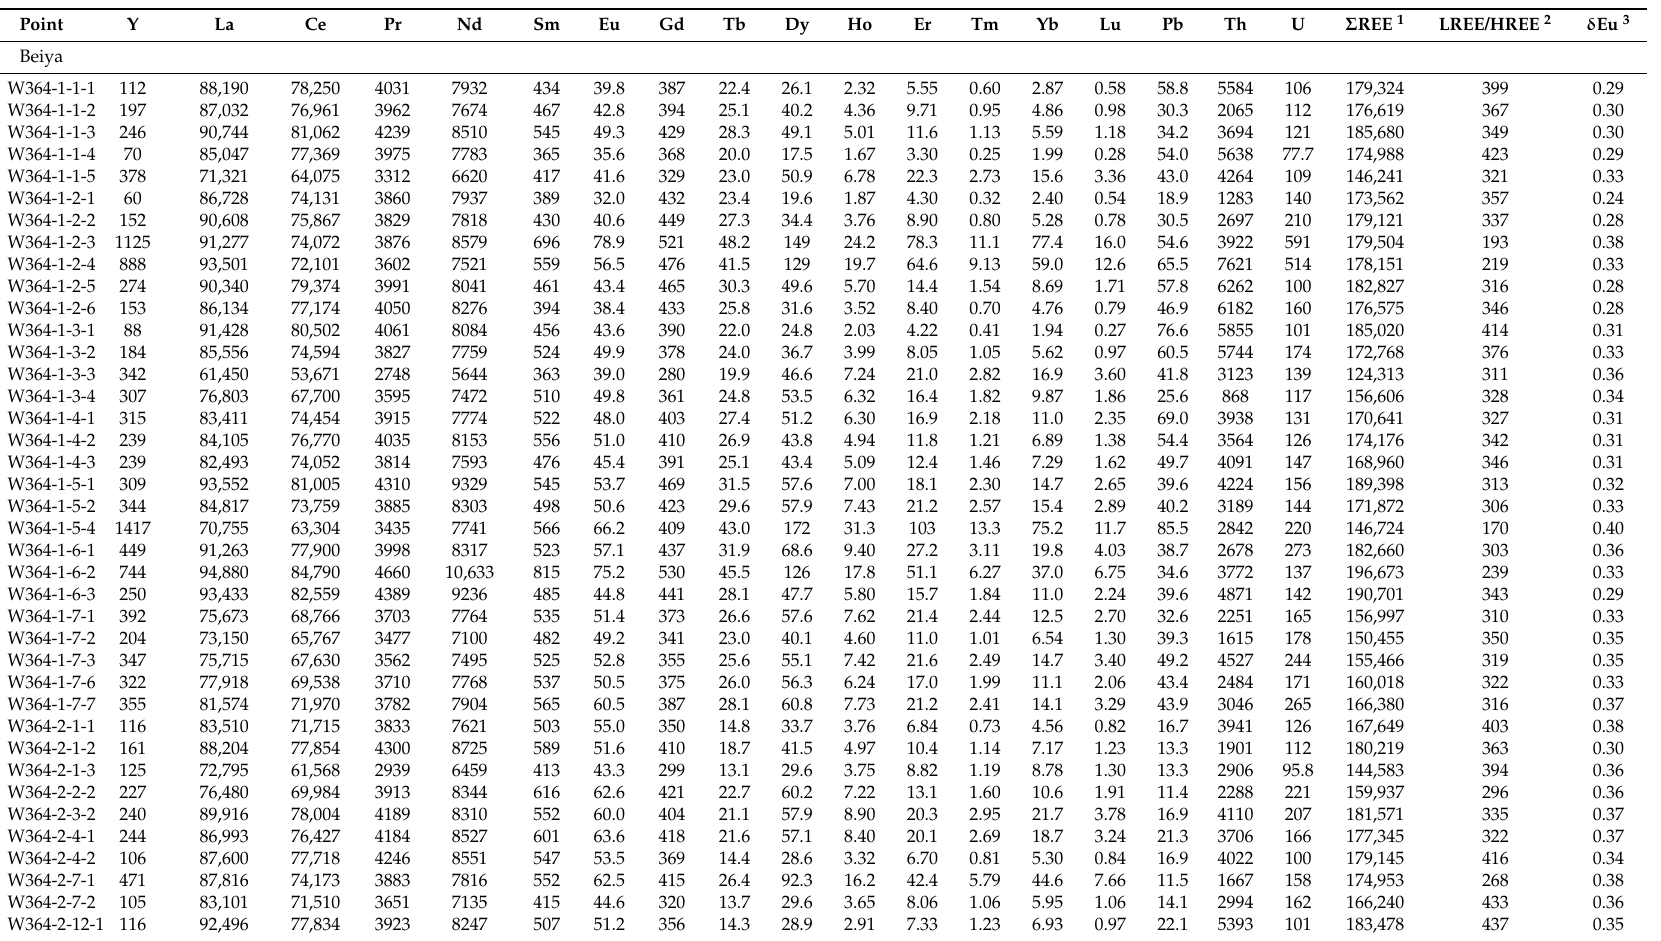
Table A2. Trace element analysis result (ppm) of the Beiya and Machangqing allanite by laser ablation-inductively coupled plasma-mass spectrometry